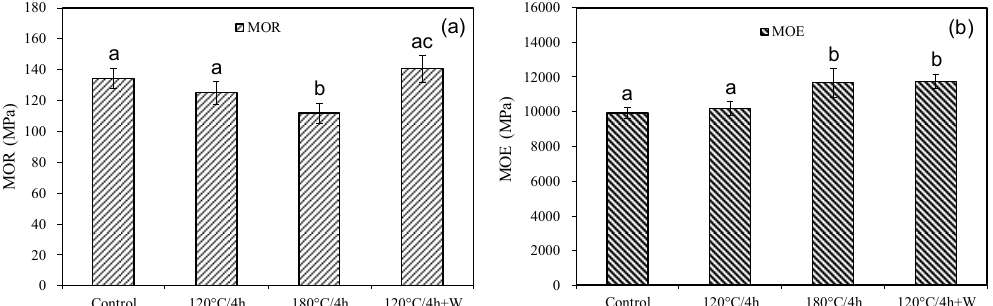
Figure 3. Mechanical properties of the control and treated wood: ( a ) MOR and ( b ) MOE. Bars with different letters indicate significant difference ( p < 0.05) in accordance with Duncan’s multiple range tests. Note: There are no significant differences between groups containing the same letters. The bar with ac means that there are no significant di ff erences between this group and groups containing a or